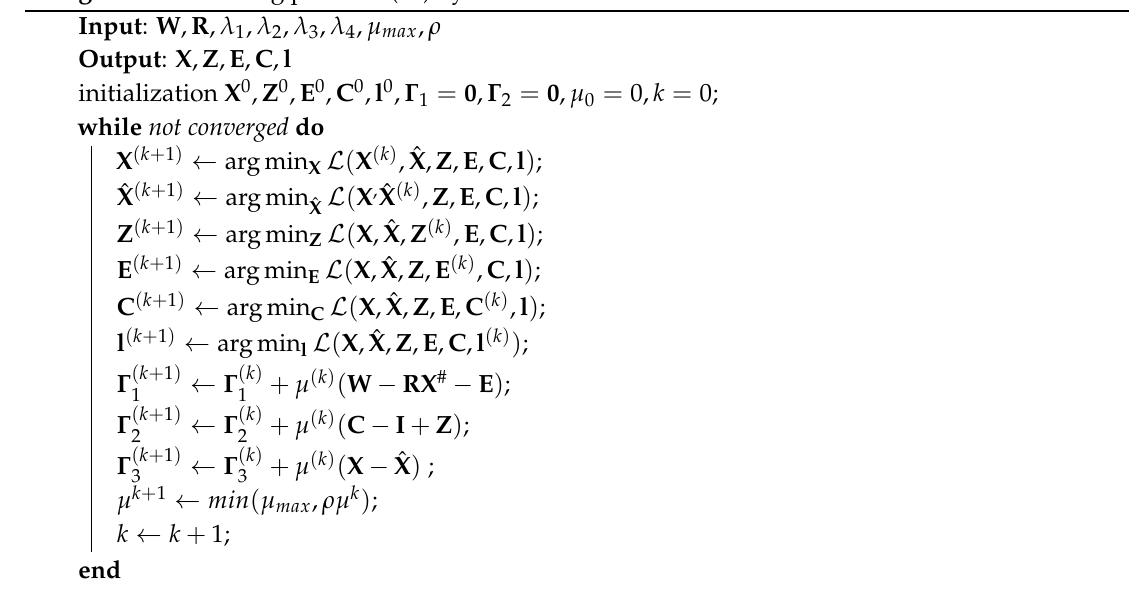
Algorithm 1: Solving problem (12) by